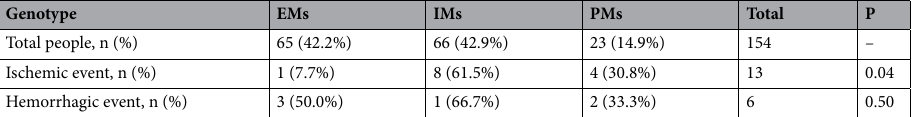
Table 3. Postprocedural clinical efficacy by phenotype group. EMs, extensive metabolizers; IMs, intermediate metabolizers; PMs, poor